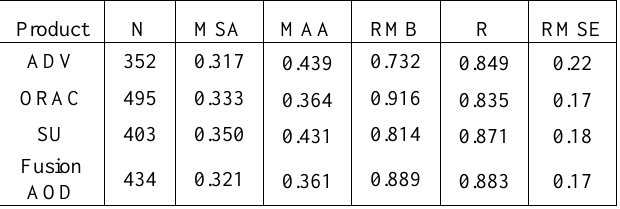
Table 2. Main statistics of the validation results